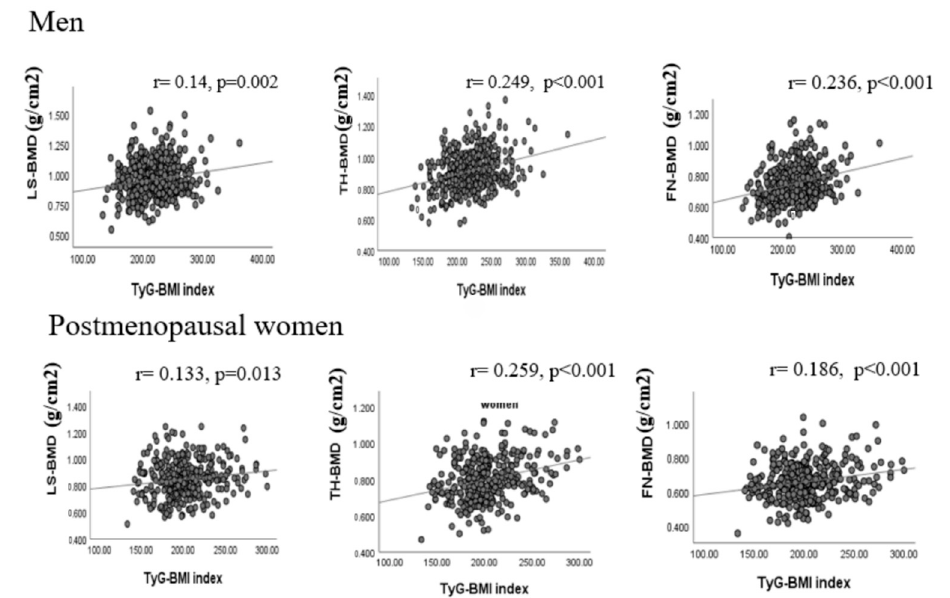
Figure 1. Correlations of serum TyG-BMI level with BMD. FN: femoral neck; TH: total hip; LS: lumbar spine; BMD: bone mineral density; TyG: triglyceride glucose index, TyG-BMI: combined TyG and BMI. Table 2. Correlations of triglyceride glucose–body mass index and bone strength and risk of fracture. Men